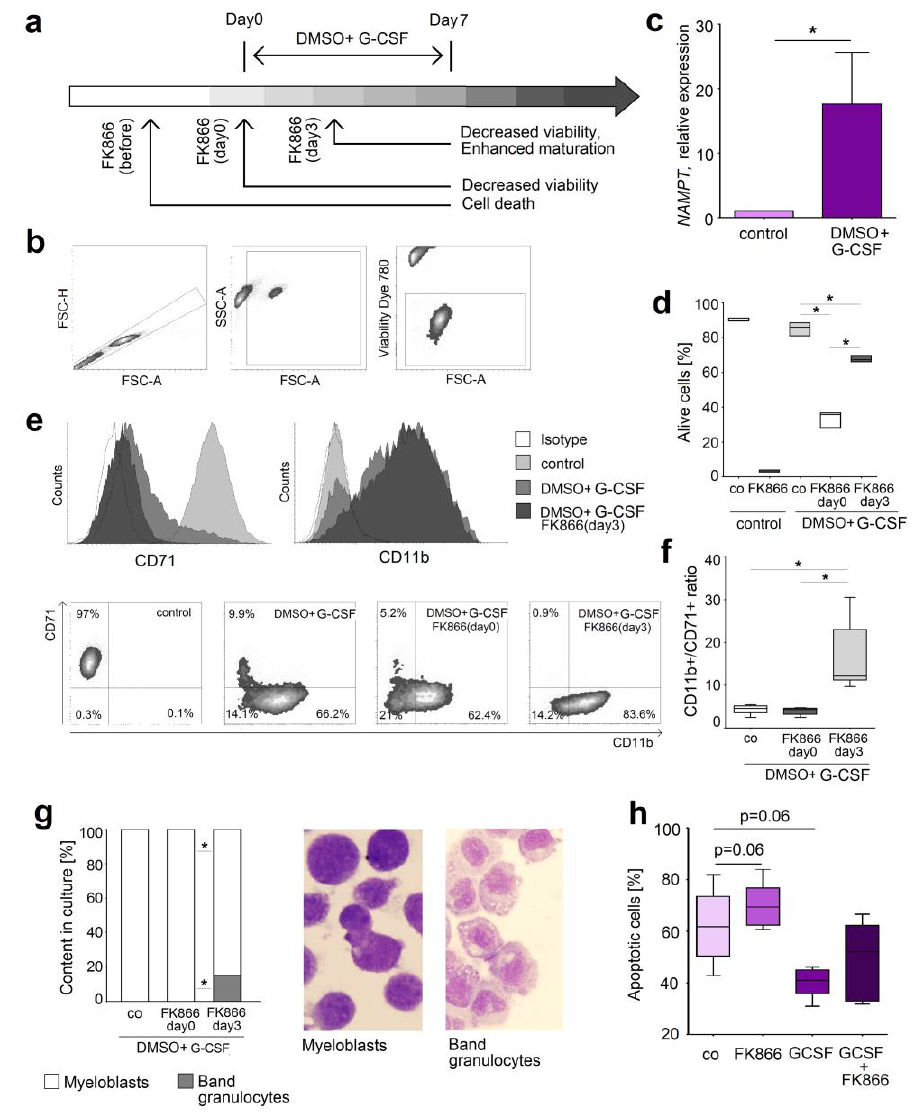
Figure 6. NAMPT inhibition increased apoptosis and induced maturation of the human neutrophil-like cell line HL-60. ( a ) The scheme of the experiment. Maturation of HL-60 cells into neutrophils was induced with DMSO and G-CSF, and treatment with FK866 was performed at di ff erent time points (at the beginning or 3 days after); ( b ) Gating strategy for single alive cells; ( c ) NAMPT gene expression is increased in HL-60 cells supplemented with DMSO and G-CSF in comparison to the control condition; ( d ) FK866 treatment at late stages of HL-60 di ff erentiation led to moderately decreased viability; ( e,f ) FK866 treatment at late stages of HL-60 di ff erentiation led to increased expression of maturation marker CD11b and decreased expression of marker of immature cells CD71; ( g ) FK866 treatment at late stages of HL-60 di ff erentiation was associated with mature phenotype of the cells. Nuclear morphology was assessed after Giemsa staining using a light microscope in at least 10 fields of view; n = 4; ( h ) FK866 treatment decreases and G-CSF increases the viability of isolated neutrophils from healthy donors. n = 4. Data are presented as median, minimal and maximal values. * p <